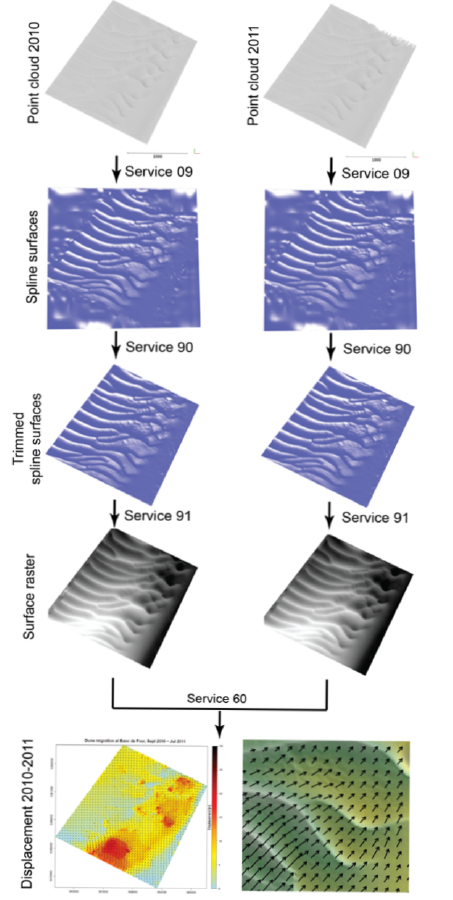
Figure 1: Marine Sand Dunes displacement: Complete workflow from original point clouds (top) over LR-spline surfaces (middle) to final result visualization (bottom) ular hierarchical level has finished and while the the computation continues on the next finer level. The complete workflow is im- plemented as a series of modular services which can be called in isolation or as a sequence sharing the same HDFS storage and cloud infrastructure. All illustrations are based on processing re- sults derived from two MBES surveys of the Banc de Four dune field (offshore Western Britanny, France) covering approximately 10 km 2